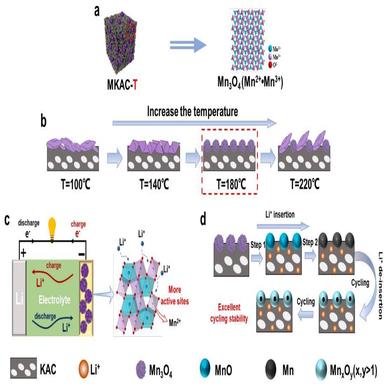
(a) The crystal structure of Mn3O4, (b) The structural evolution of four different MKAC-T materials, (c) The energy storage mechanism of MKAC-180 anode electrode, (d) The structure and phase evolution of MKAC-180 anode electrode.